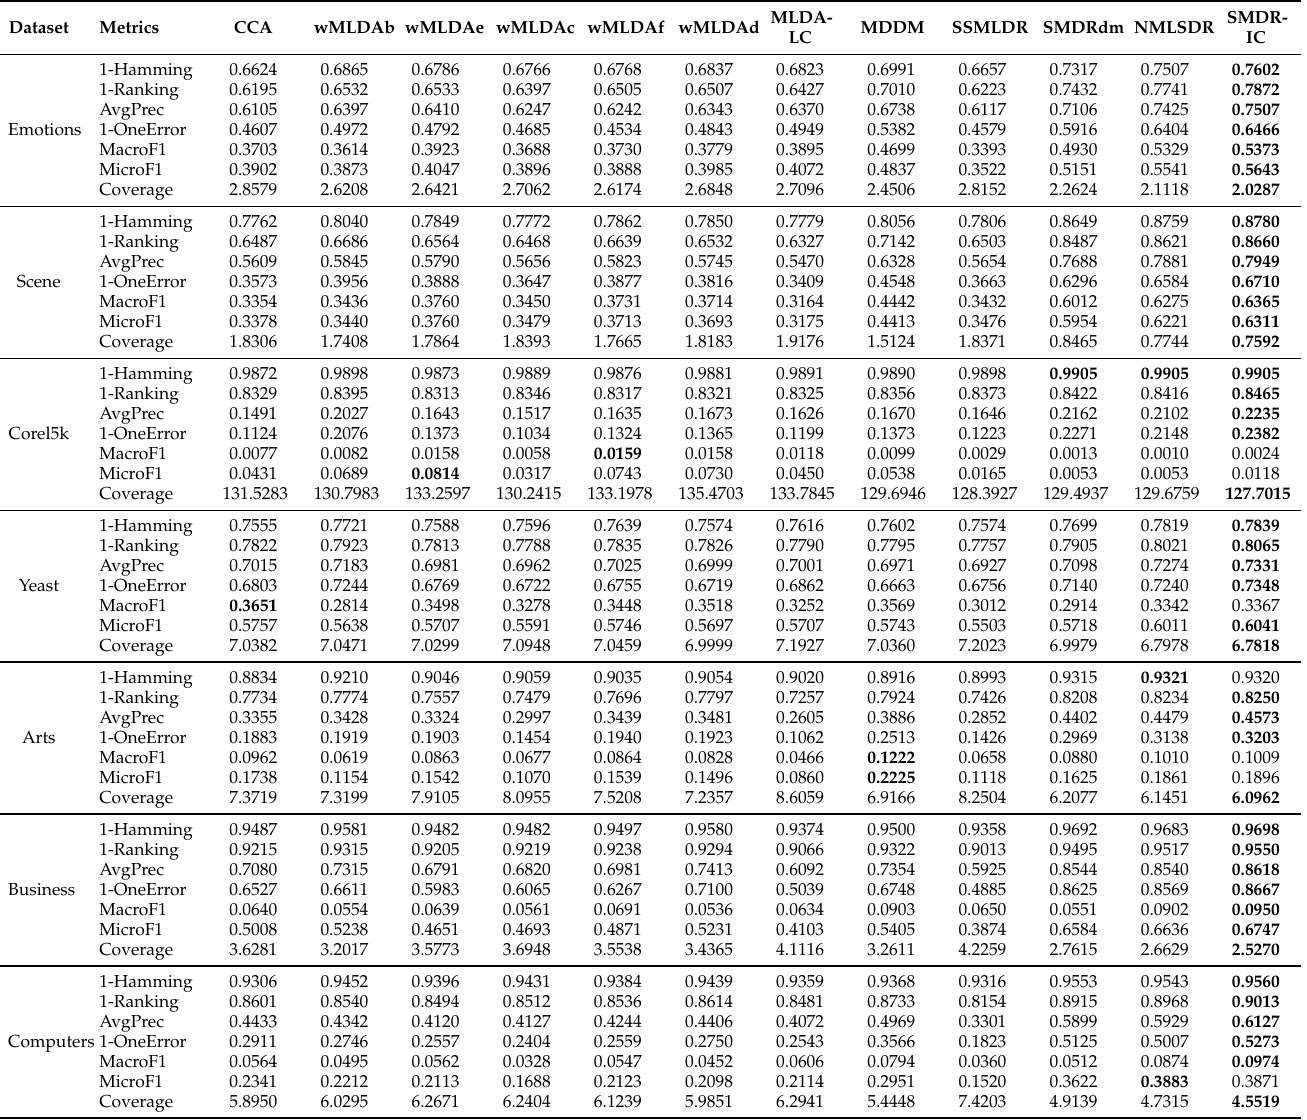
Table 2. Experimental results of 20% labeled instances on fifteen data sets in terms of seven evalua- tion